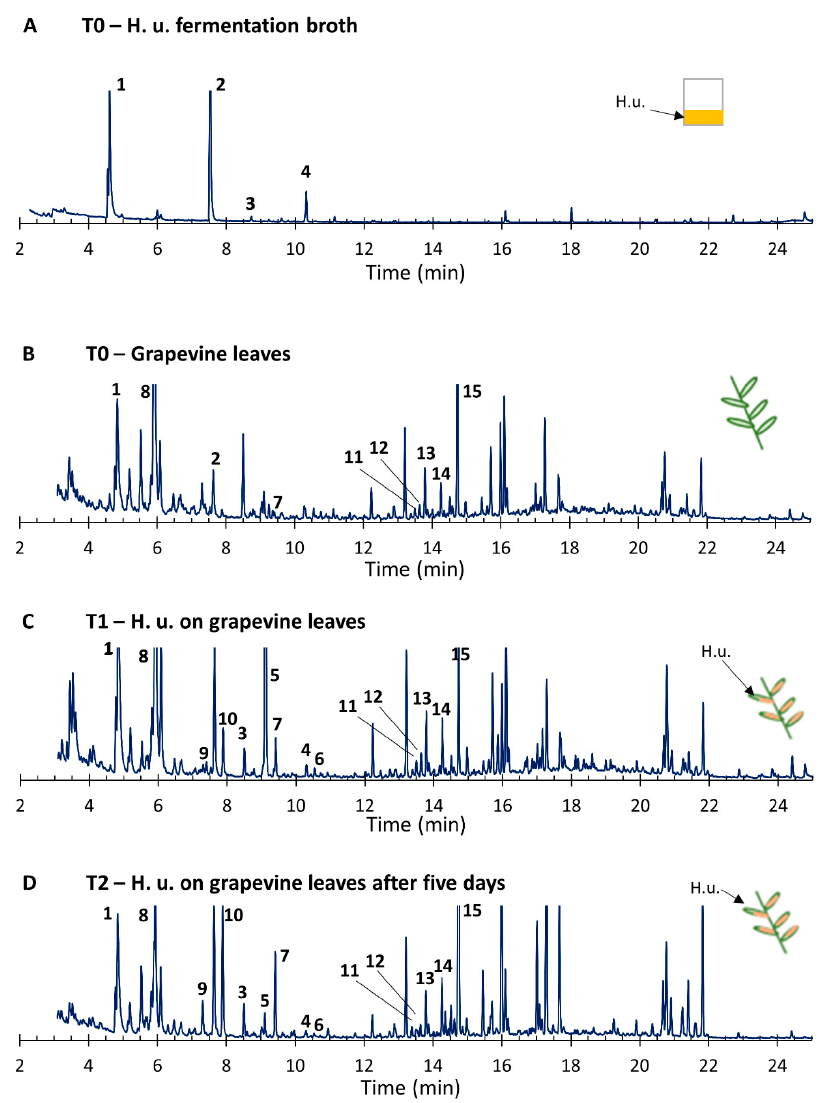
Figure 7. Chromatogram from headspace extracts of H. u. fermentation broth ( A ), grapevine leaves ( B ), grapevine leaves with H. u. 30 min after application ( C ), grapevine leaves with H. u. 5 days after application ( D ). All headspaces were collected with close loop stripping analysis (CLSA) for 3 h. Chemicals identified from H. u. are reported: 1. benzaldehyde; 2. 2-phenylethanol; 3. octanoic acid; 4. 2-phenylethyl acetate; 5. methyl salicylate; 6. indole; 7. ( Z )-3-hexenyl butyrate; 8. 1,8-cineole; 9. linalool; 10. ( E )-4,8-dimethylnona-1,3,7-triene (DMNT); 11. beta-caryophyllene; 12. humulene; 13. germacrene D; 14. trans-alpha-bergamotene; 15. ( E,E )- alpha–farnesene. All graphs are on the same scale showing the total ion chromatogram peaks in